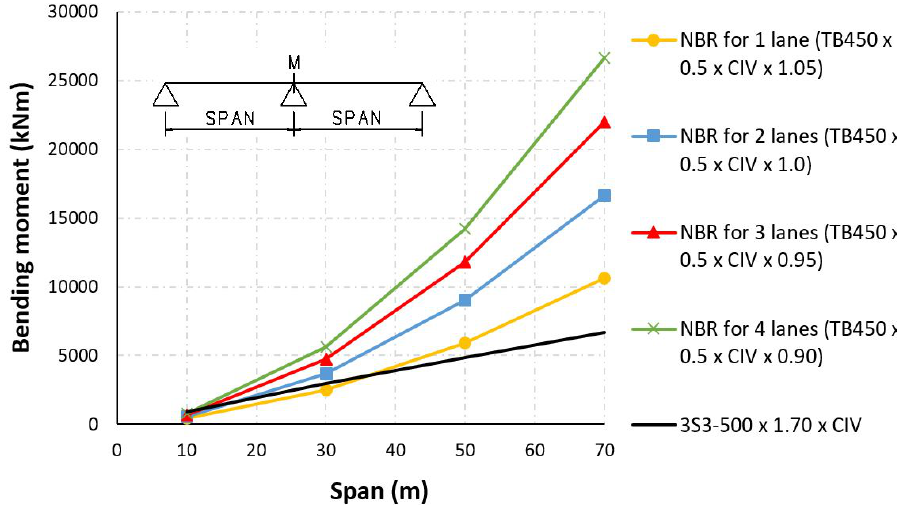
Figure 26. Comparison between models for bending moment at support in continuous